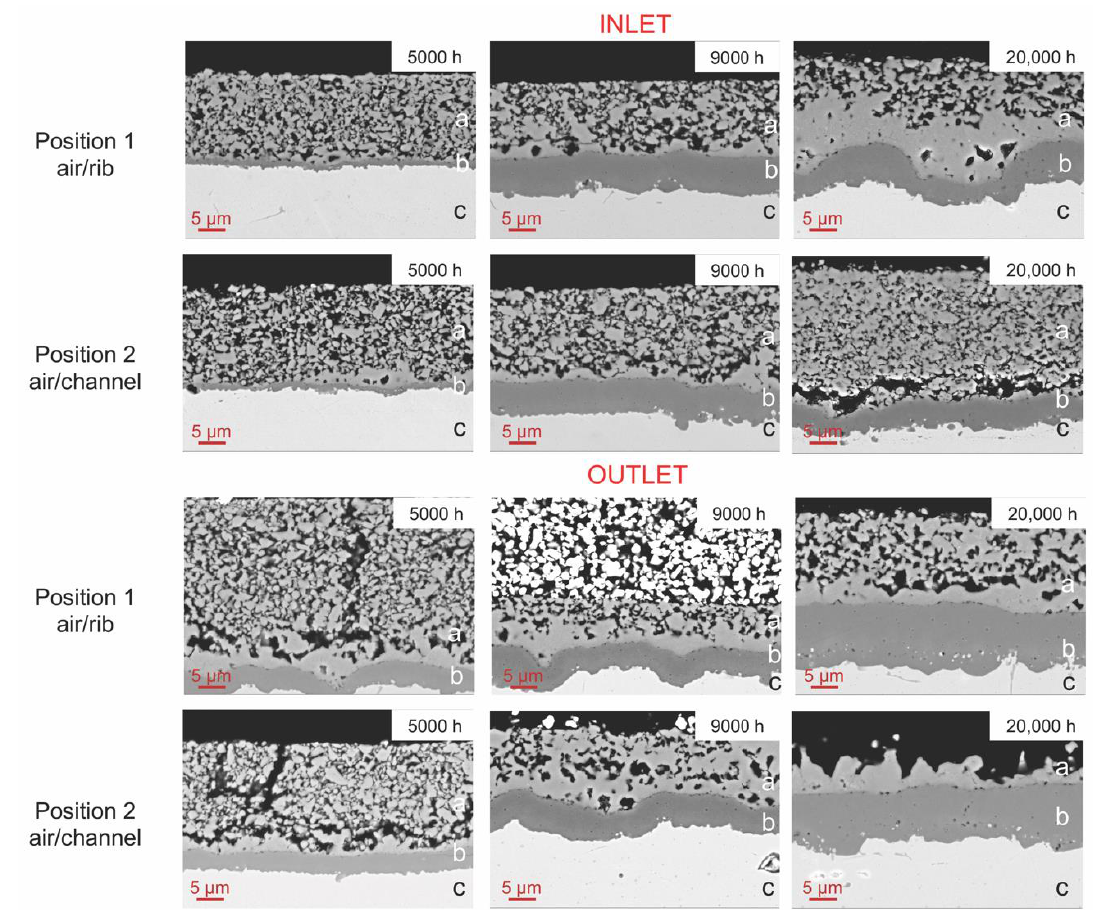
Figure 3. SEM-BSE micrographs of the position 1 (air / rib interface) and position 2 (air / channel interface) from 5000 to 20,000 h. The phases as labelled as follows: ( a ) MCO; ( b ) thermally grown oxide (TGO); ( c ) ferritic stainless steel (FSS). The white porous phase above the MCO at OUT 9000 h is the LSCM contacting paste. Table 3. Thickness variation of the TGO according to the exposition time, site of interest and sampling site. Average values with standard deviations in thickness on at least 5 measurements.